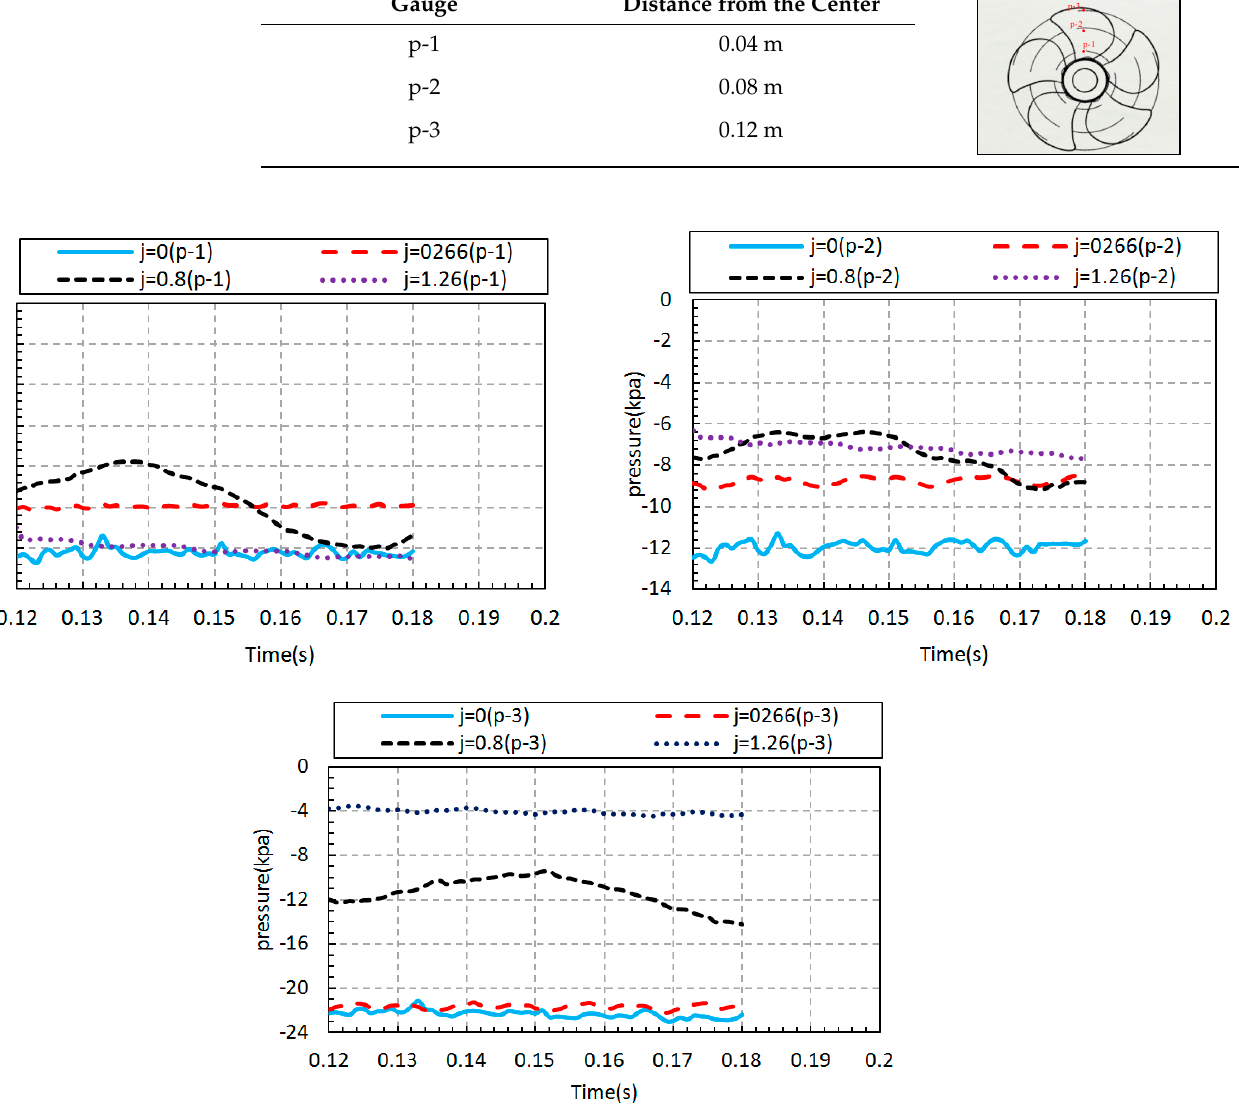
Figure 6. Integral forces act on the propeller at the different advanced coefficients. Figure 5. Gauge pressure variations of one rotation (t = 0.12 s-t = 0.18 s) for different advanced coefficients.